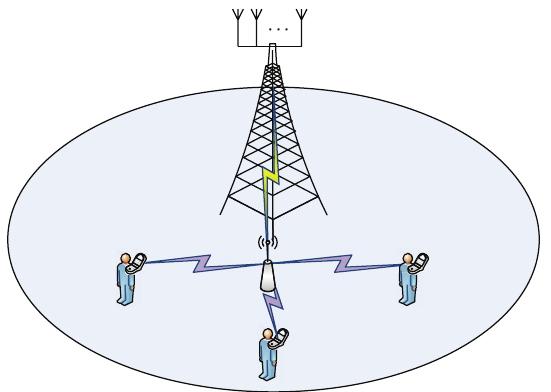
Figure 5: Multiuser communication through a single